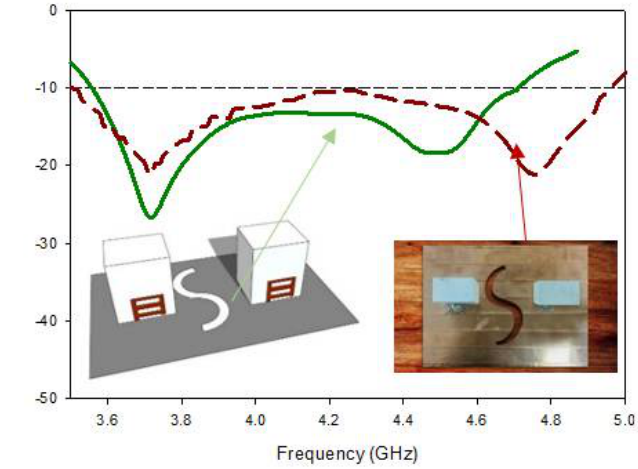
Figure 16. Comparison of the return loss of the fabricated and simulated MIMO antenna.